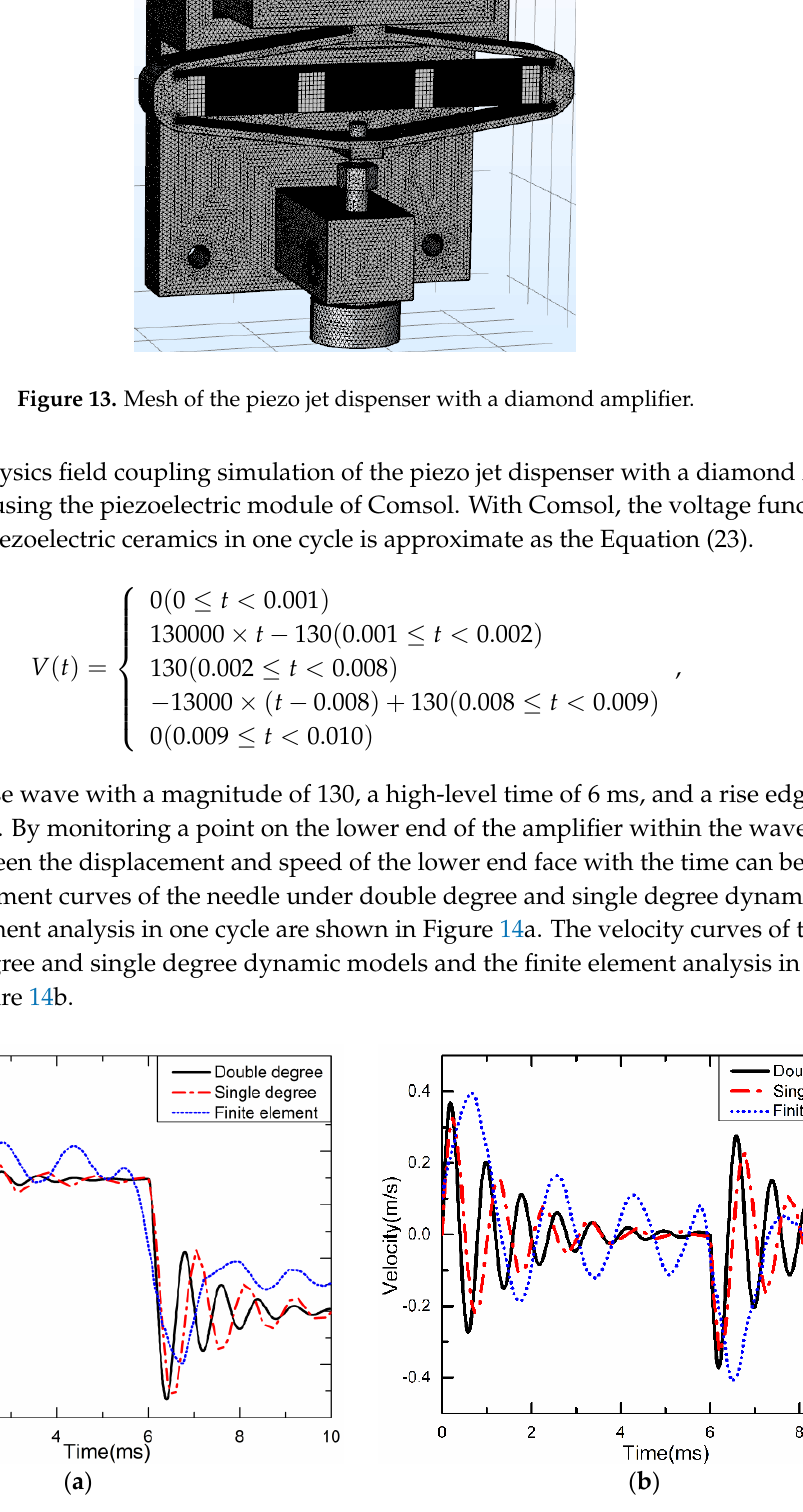
velocity graph. velocity